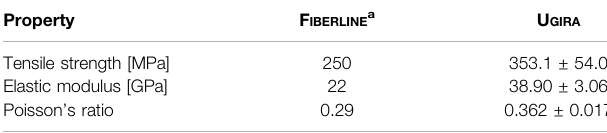
TABLE 2 | Material properties of the GFRP composites. Property